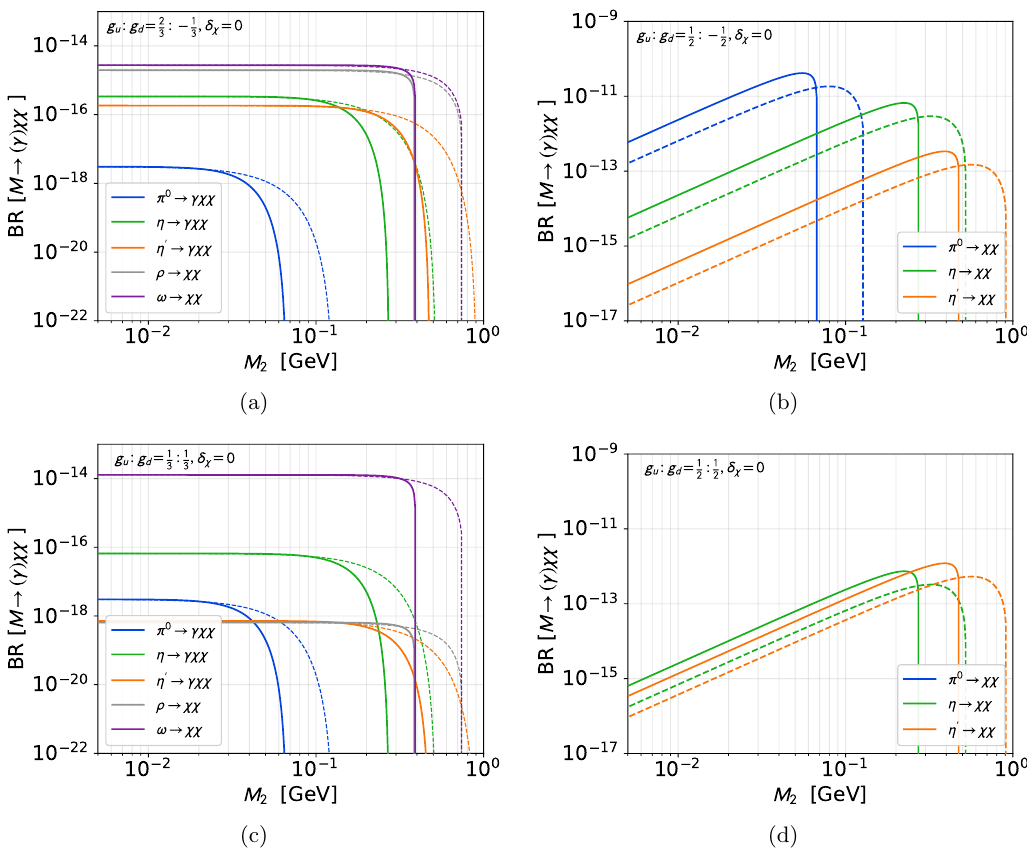
Figure 1 . Branching ratios as a function of dark sector fermion mass for various meson decays for (a), (c) the vector-current operator and (b), (d) the axial-vector operator, with (cid:14) (cid:31) = 0 ( (cid:14) (cid:31) = 20) between the dark sector states in solid (dashed) lines. The upper and lower (cid:12)gures show the e(cid:11)ect of changing the relative couplings to up- and down-quarks. Couplings to strange-quarks have been assumed to align with the down-quark